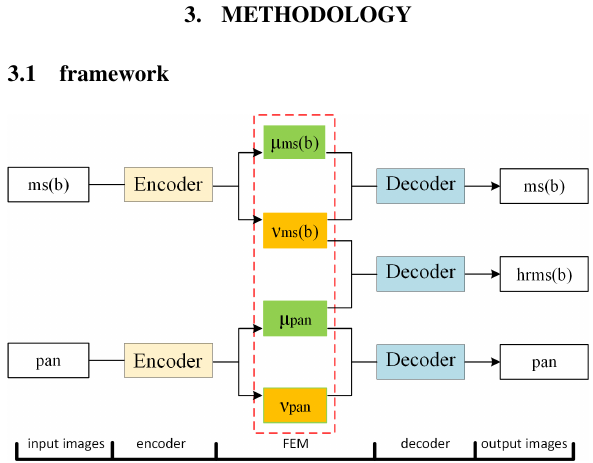
Figure 1. Framework of the proposed component substitution network. The FEM is inside the red dotted